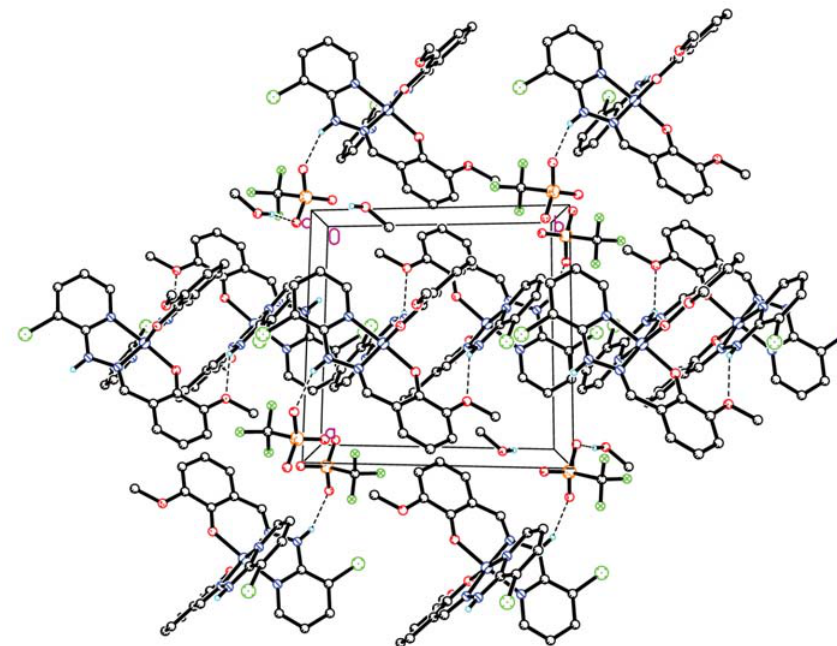
Figure 6. Packing diagram of 2 viewed along the c axis. Hydrogen bonds are shown as dashed